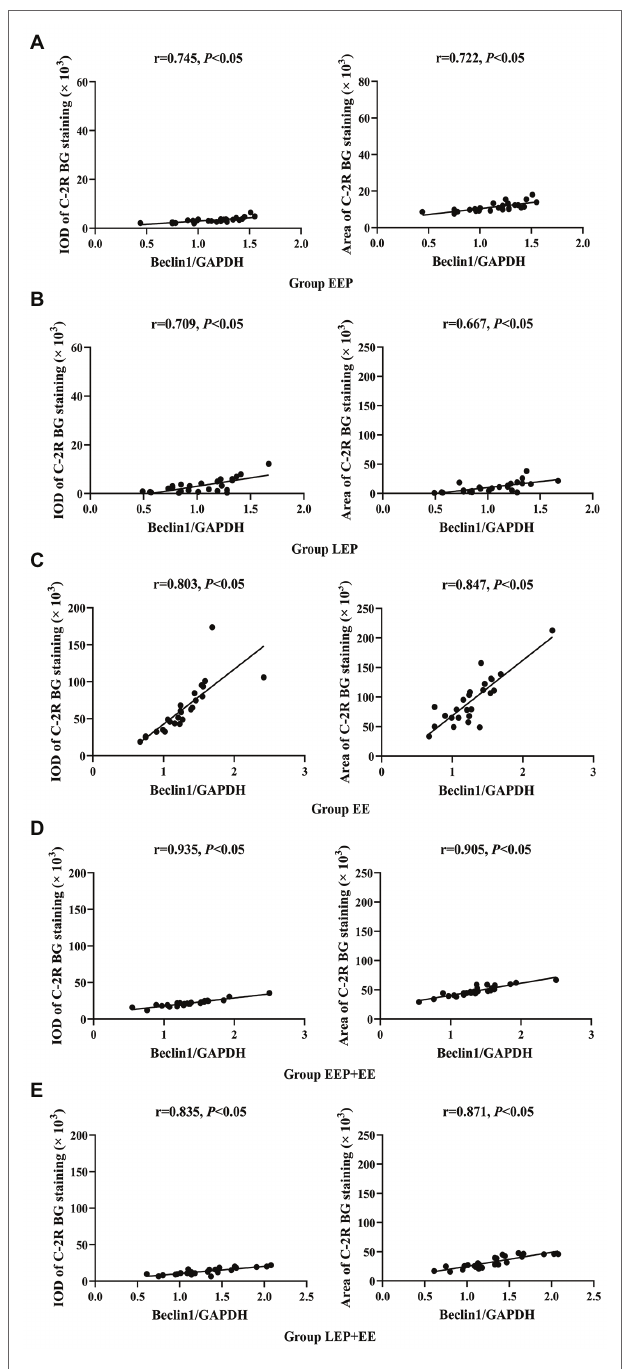
FIGURE 3 | Correlation between ischemia-hypoxia and Beclin1 levels between groups. (A) Group EEP. (B) Group LEP. (C) Group EE. (D) Group EEP + EE. (E) Group LEP +